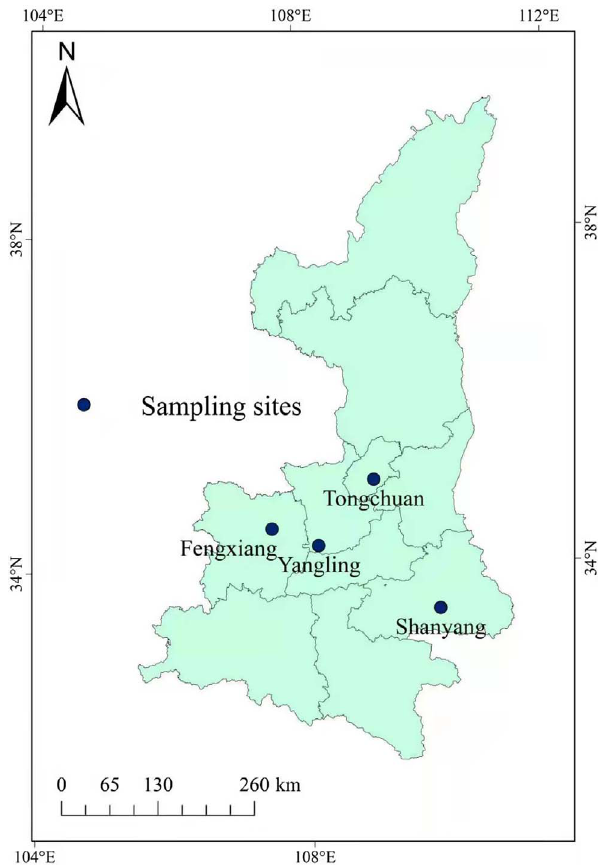
Figure 1. Sampling sites in this